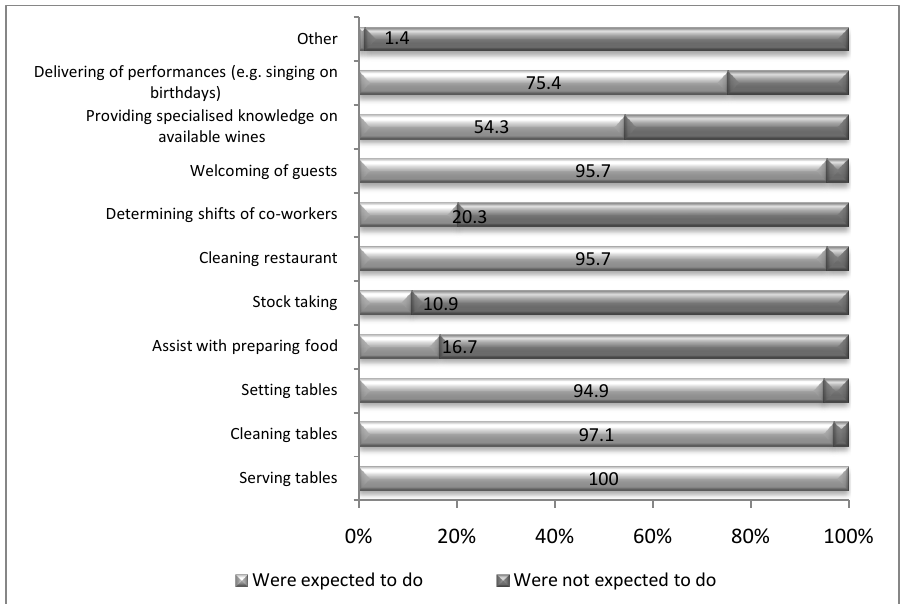
FIGURE 8: Tasks that waiters in Kempton Park are to perform, 2008 Source: Survey data